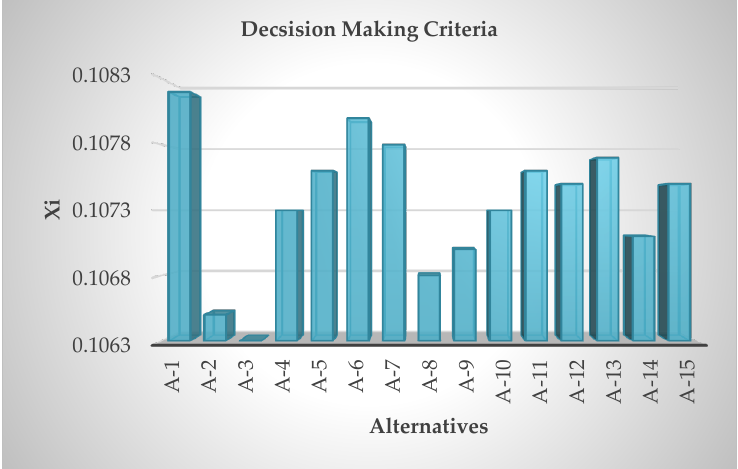
Figure 15. Zoomed version of decsision-making criteria based on equally weighted indices scenario.